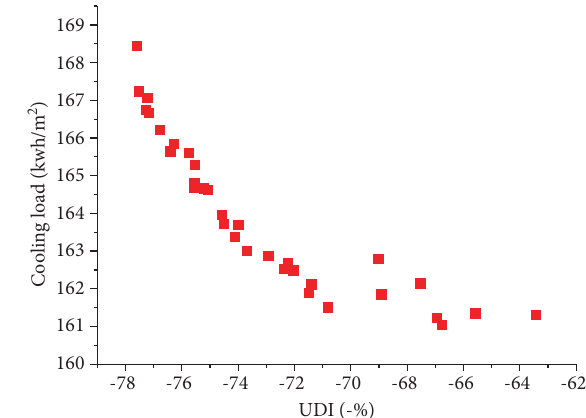
Figure 9: UDI and cooling load performance of nondominated solutions in the 51st iteration.